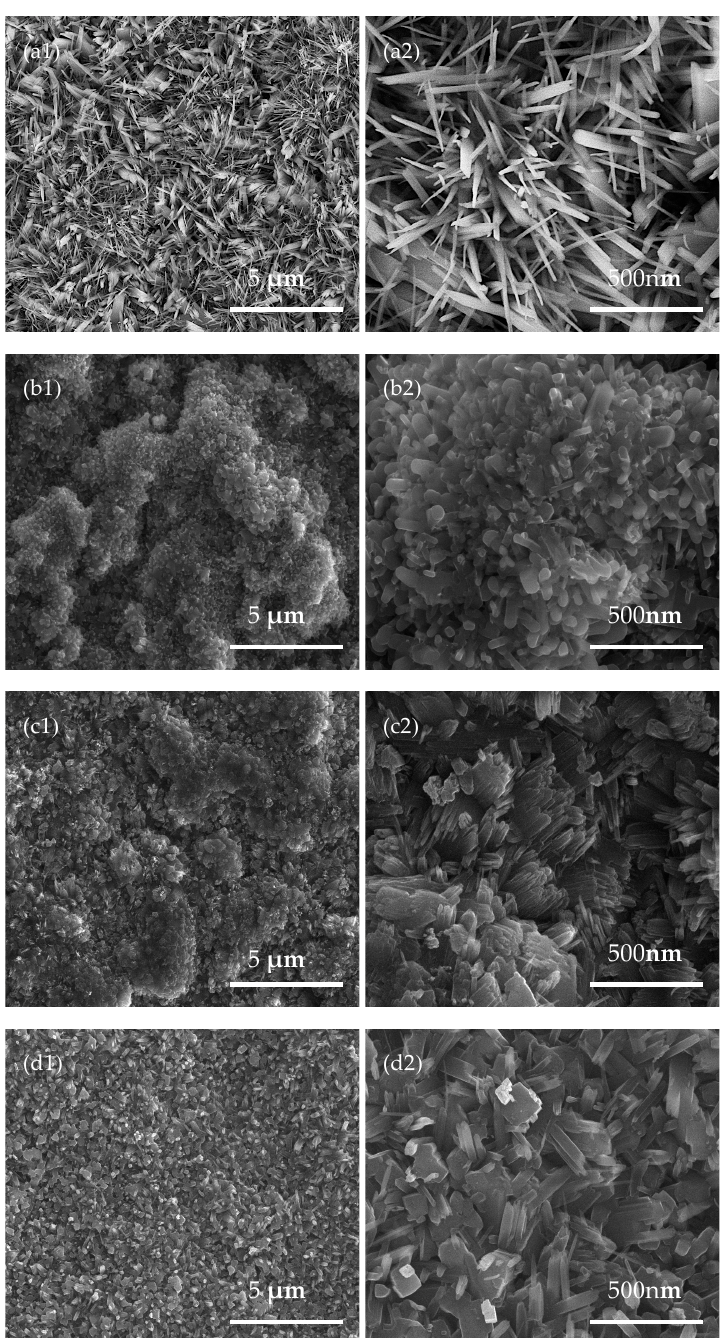
Figure 5. SEM images of ( a1 ), ( a2 )—TNW475, ( b1 ), ( b2 )—TNW500, ( c1 ), ( c2 )—TNW550, and ( d1 ), ( d2 )—TNW600. TNW: titania